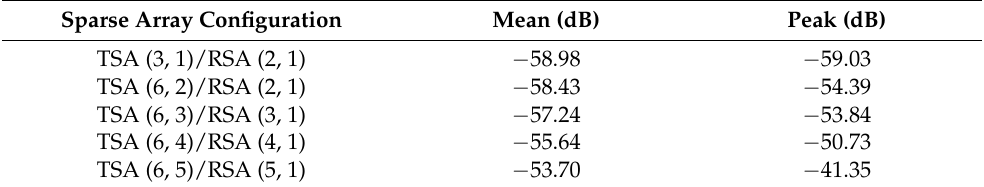
Table 2. Comparisons of mean and peak side-lobe levels in the region − 30 ◦ < θ < 30 ◦ for different sparse array